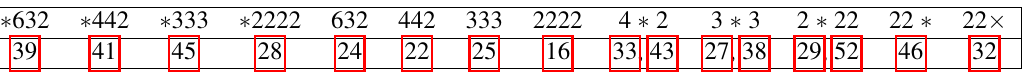
Tab. 3: Symmetry groups with corresponding figure